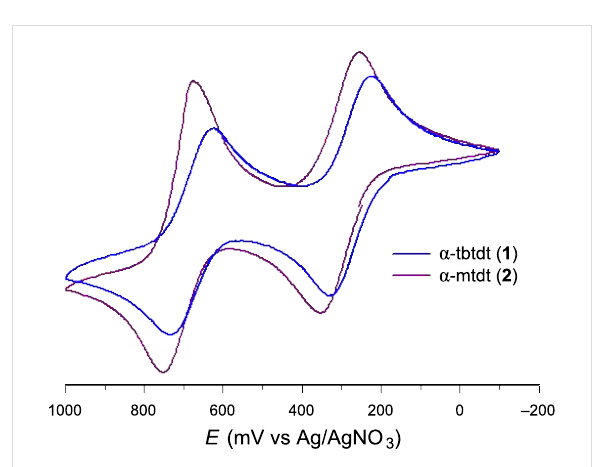
Figure 1: Cyclic voltammogram of α -tbtdt ( 1 ) and α -mtdt ( 2 ) (10 − 3 M) in dichloromethane versus Ag/AgNO 3 , with n -Bu 4 NPF 6 (10 − 1 M) as supporting electrolyte. Scan rate ν = 100 mV/s at room